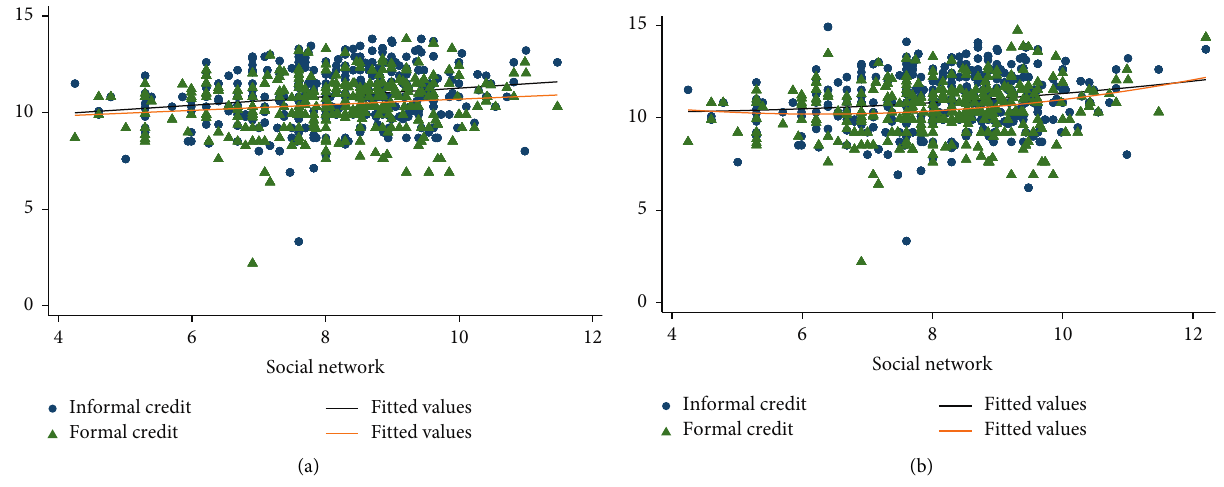
Figure 4: Slope graph of social networks on formal and informal credit behavior. (a) Linear fitting; (b) curve fitting. Table 5: Impact of emotional and instrumental social networks on rural household credit